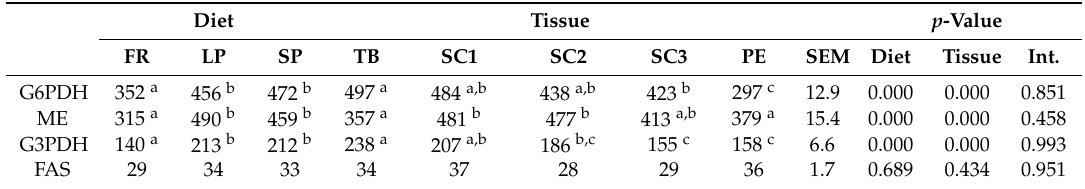
Table 2. E ff ect of diet and adipose tissue on the lipogenic enzyme activities of backfat and perirenal fat from Iberian pigs. Results are expressed in nmol of nicotinamide adenine dinucleotide phosphate (NADPH) produced (ME, G6PDH) or consumed (FAS), and NADH consumed (G3PDH) per min and per g